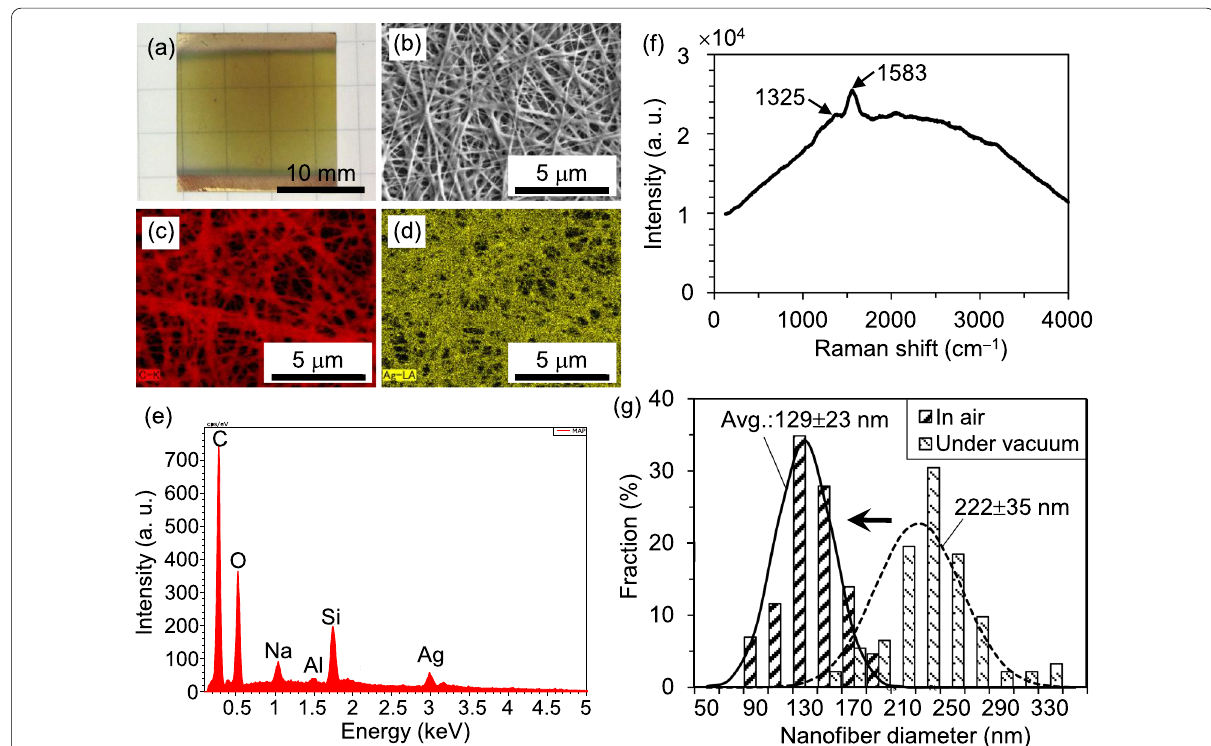
Fig. 3 Specimen after heating under vacuum with a optical image and EDX analysis results: b SEM, c C, and d Ag distribution mappings; e qualitative analysis of the area shown in ( b ); and f the Raman spectrum. g Histograms of the NF diameter after heating in air and under